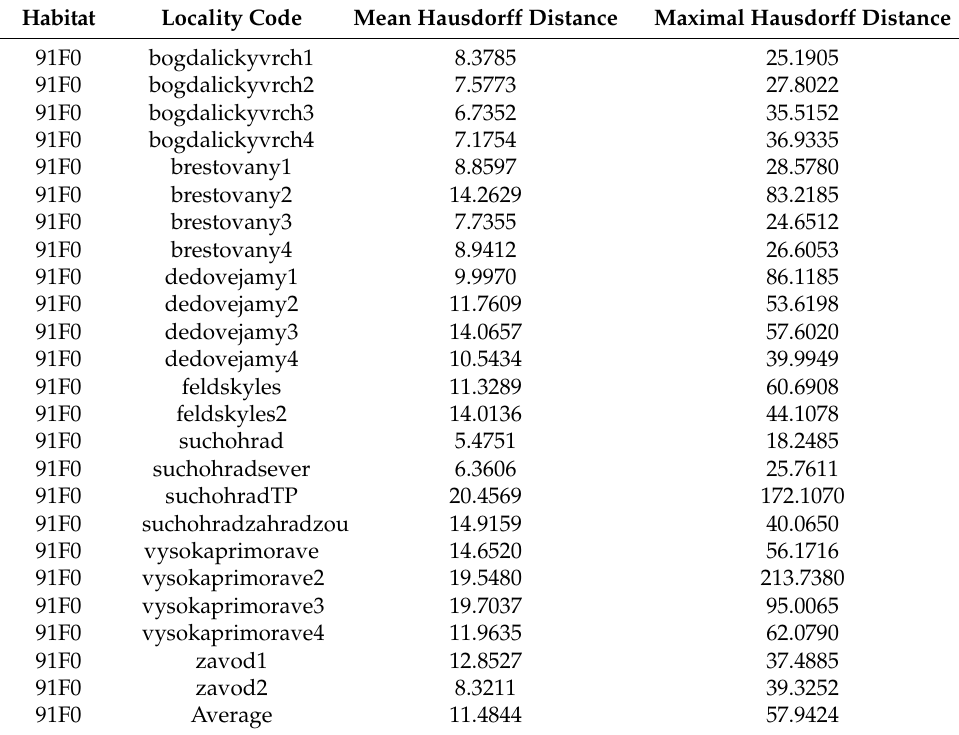
Table 1. The list of 91F0 riparian mixed forests localities with the mean and maximal Hausdorff distances of semi-automatically segmented and GPS-tracked boundaries.